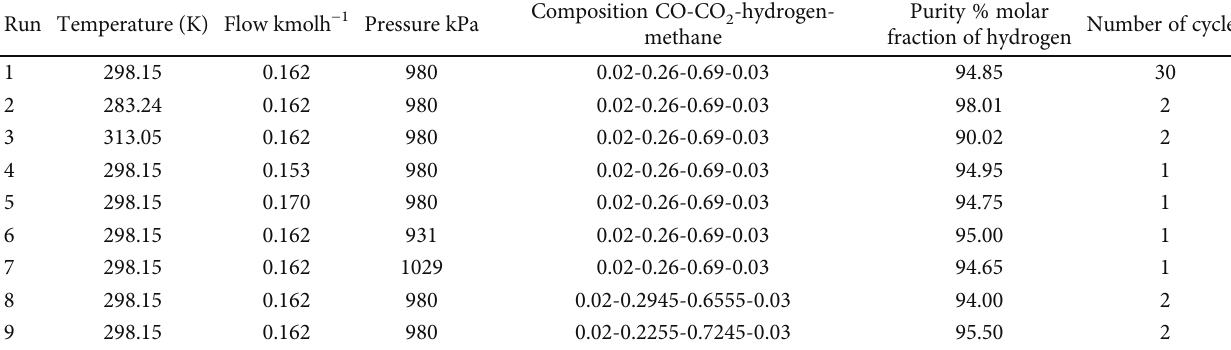
Table 13: Analysis of the possible input variables that have the greatest e ff ect on the purity